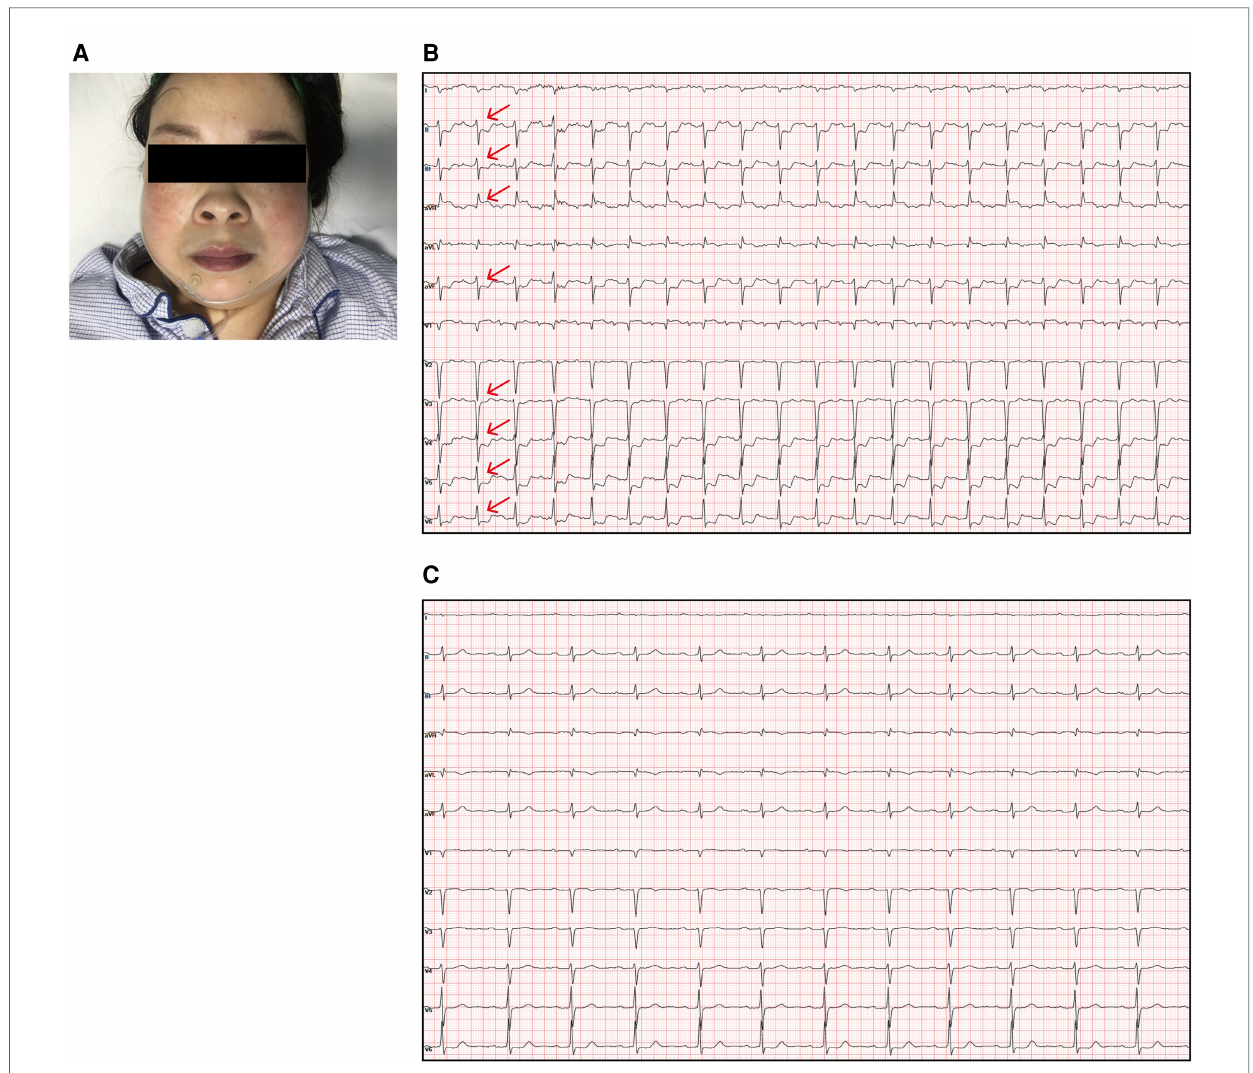
FIGURE 1 ( A ) The patient was cyanotic. ( B ) Electrocardiogram showing sinus rhythm and obvious ST-segment elevation in the aVR (red arrow) as well as depressions in the II, III, aVF, and V3 – V6 leads (red arrow) when she laid fl at and experienced angina pectoris. ( C ) The angina pectoris and ST segment abnormalities were relieved when she sat